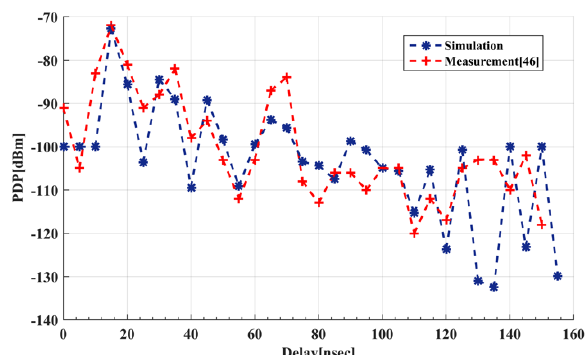
Figure 10. Comparison between the simulation and measurements.